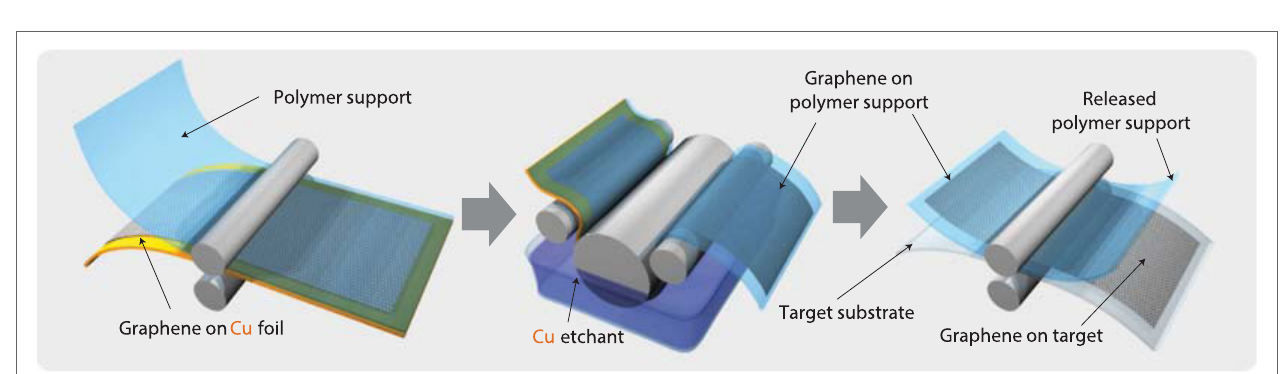
FiGURe 6 | (A) HRTEM image of graphene films with corresponding SAED pattern (inset). (B) Transmittance of a ca. 10-nm-thick graphene film (red), in comparison with that of ITO (black) and FTO (blue) (Wang et al., 2008). Copyright ACS Publications, 2008.